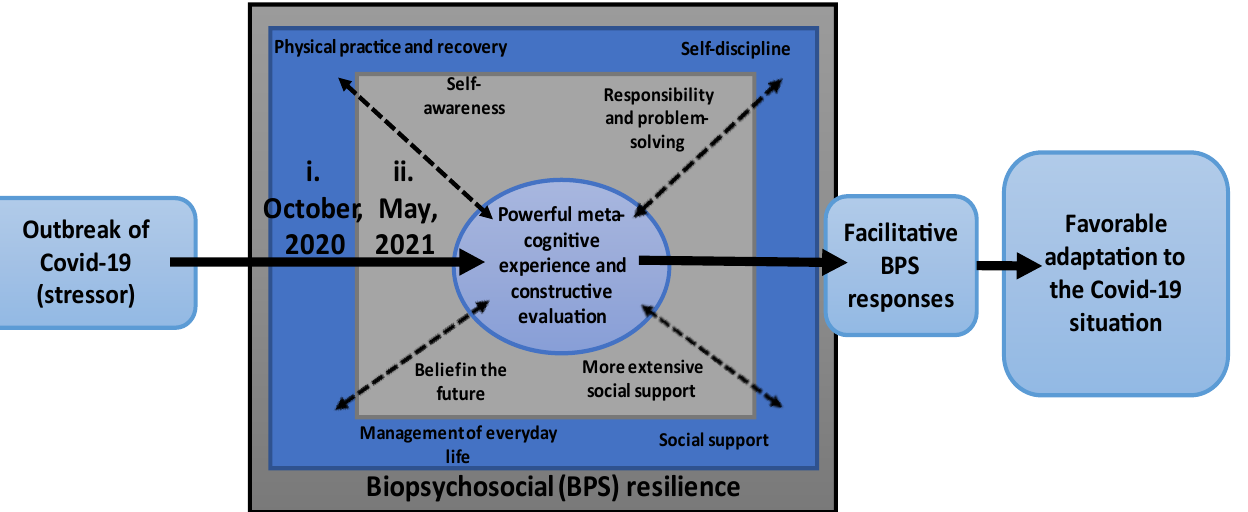
Figure 1. A longitudinal and schematic representation of the constructed main categories and the core category, illustrating their interrelationships in a grounded theory model of adaptation to SARS-CoV-2-pandemic 2020 – 2021 at a certified sport high school in Sweden. Answers belonging to i. correspond to March – October 2020 and answers belonging to ii. corresponds to the period No- vember 2020 – May 2021. Note: Parts of the construction of Figure 1 are inspired by the previous published grounded theory of psychological resilience and optimal sports performance by Fletcher and Sarkar [17], p.